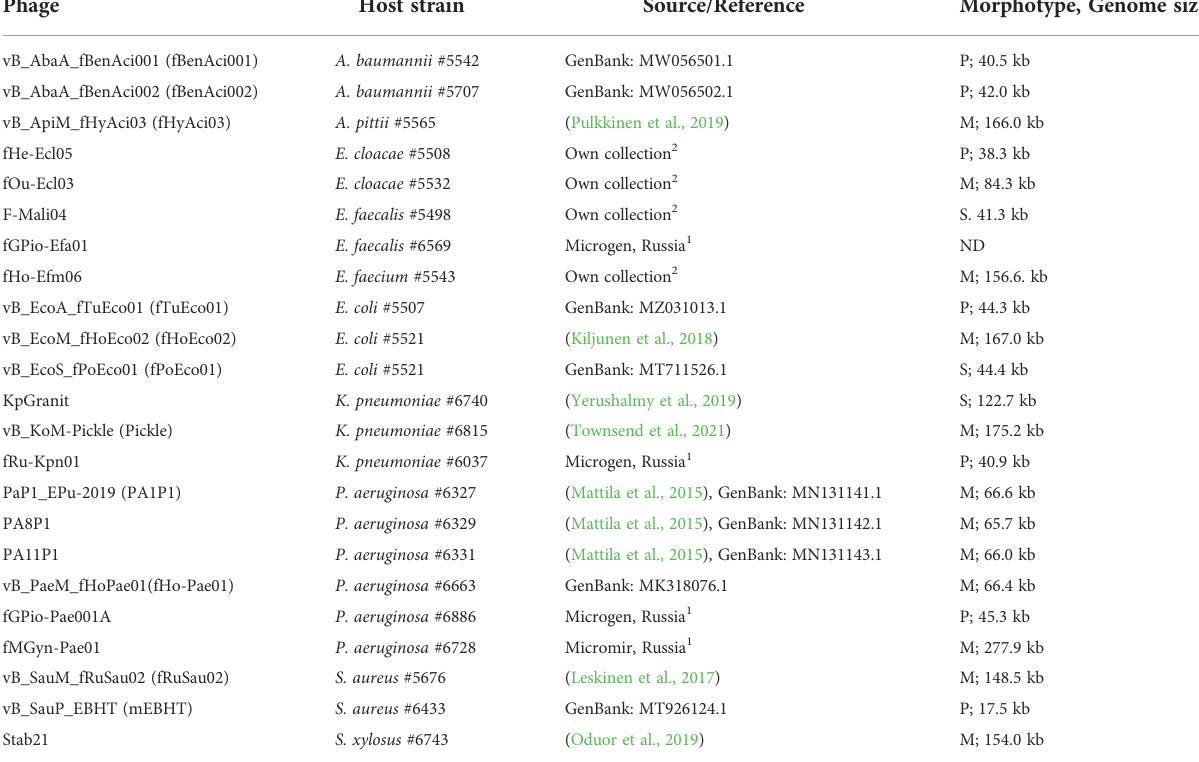
TABLE 2 Bacteriophages used in the work.